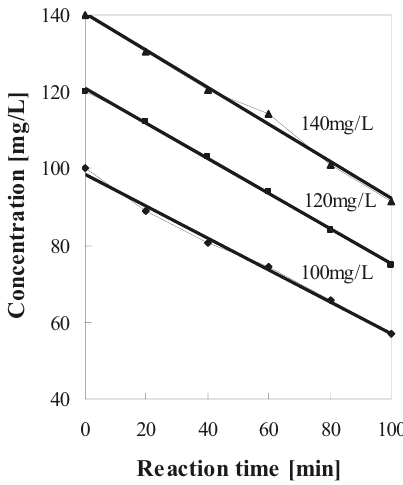
Figure 3. Plot of photocatalytic decolorization of MO vs. irradiation